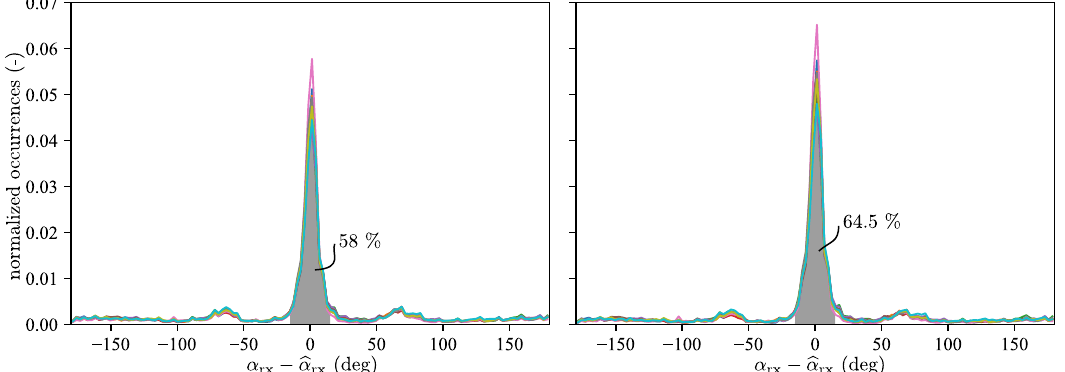
Figure 6. The error distribution of the maximum a-posteriori AOA estimate is shown for the ten different datasets using the modified spline antenna. On the left, the distribution is shown for when the maximum a-posteriori estimate is calculated using a single CIR. On average 58% of these estimates have an error of less than 15 ◦ . This value is increased to 64.5% when the maximum a-posteriori estimate is calculated using ten consecutive CIR measurements, which is shown on the